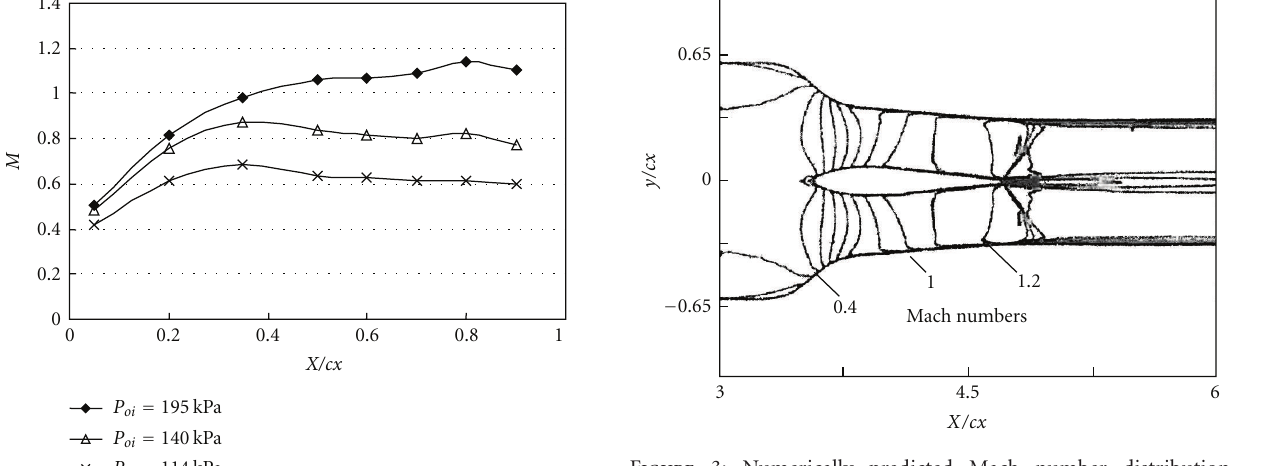
Figure 3: Numerically predicted Mach number distribution through the test section for the symmetric airfoil investigations